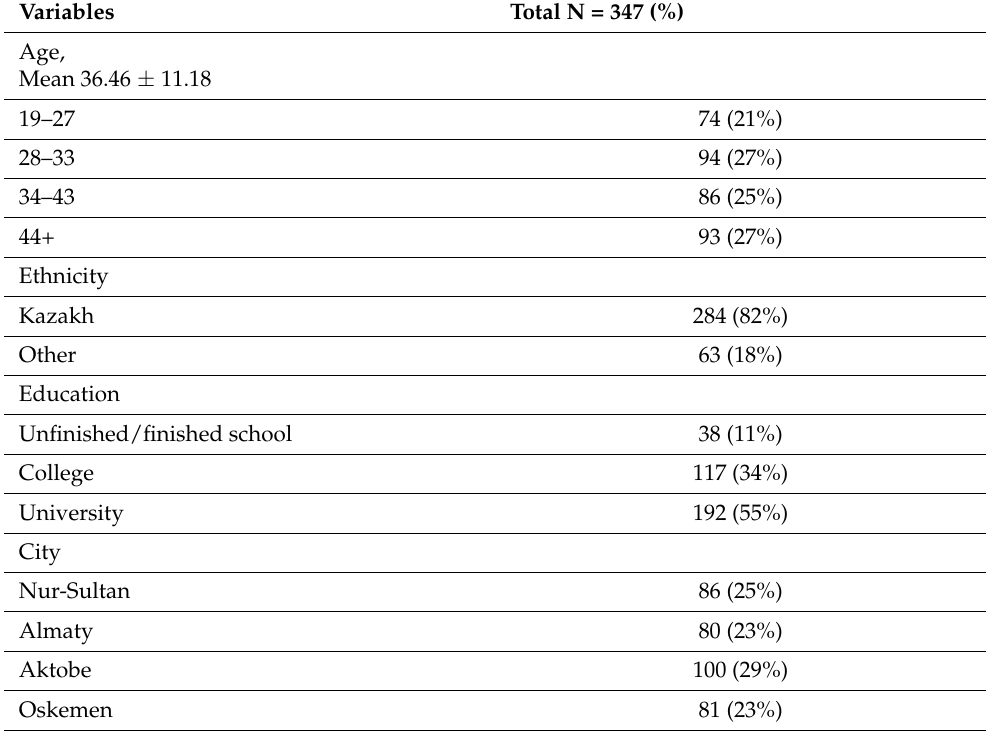
Table 1. Social and demographic characteristics of the study participants (N =